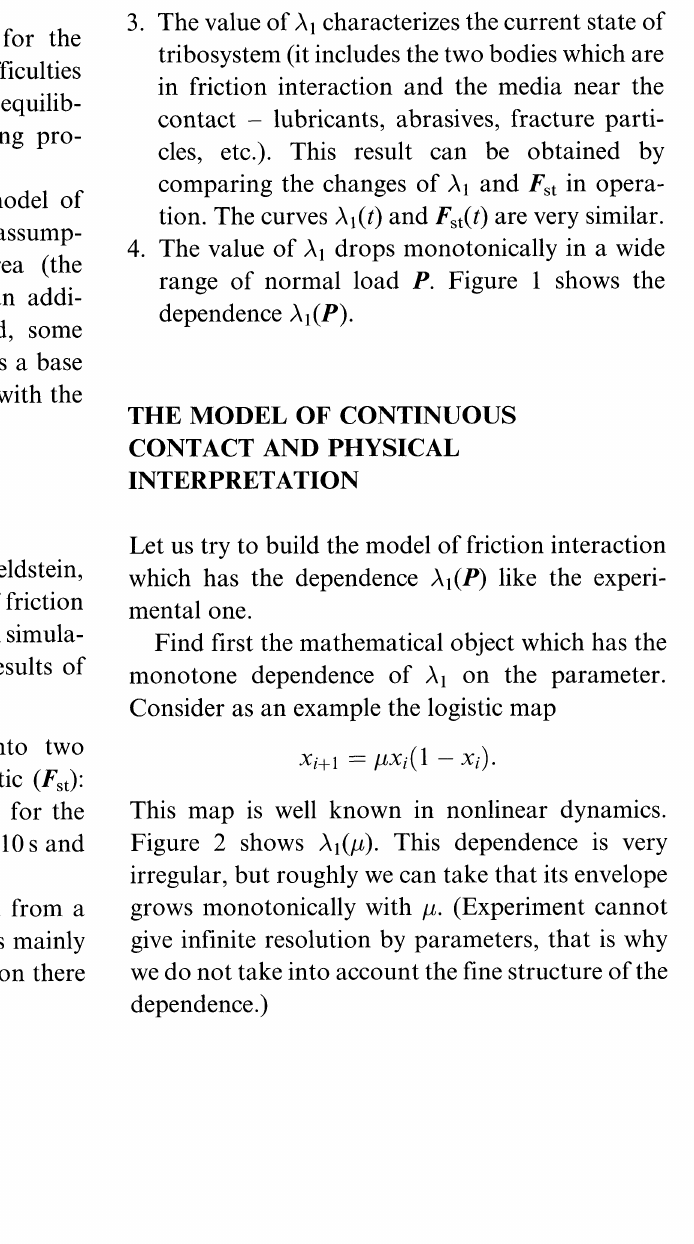
FIGURE The dependence AI(P) (from